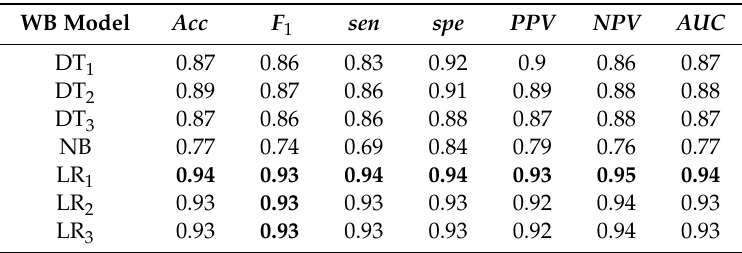
Table 6. Performance comparison of white box (WB) models.